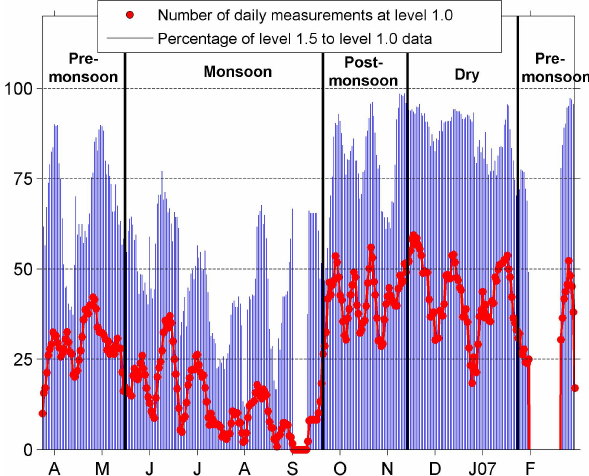
Fig. 3. Number of L1 sunphotometer measurements per day at the Ev-K2-CNR (red dots) and percent of cloud-screened, L1.5 data (blue bars) in the period April 2006–March